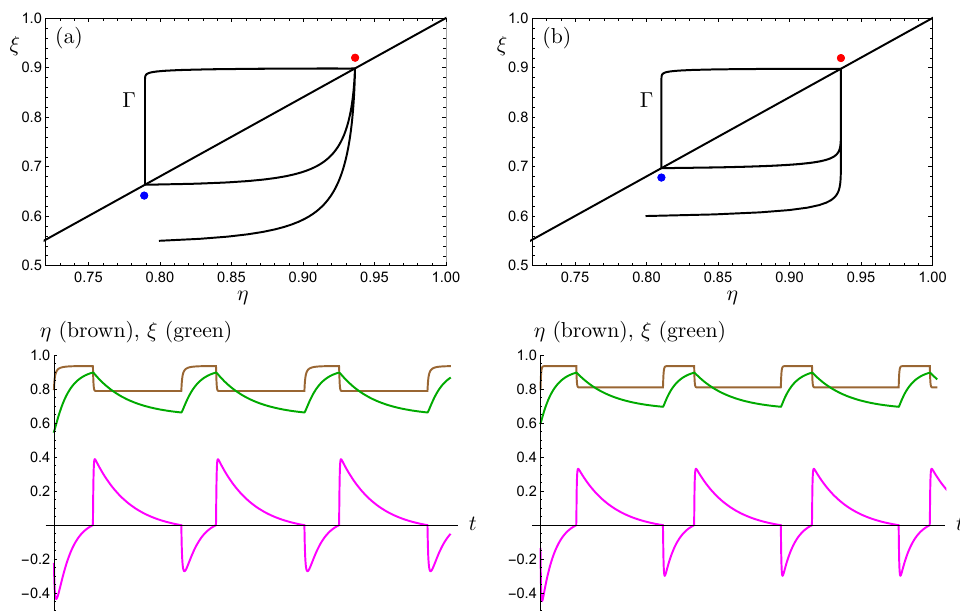
Figure 7. The limit cycle Γ for system (23) ( ρ = 0.1 R , (cid:101) = 0.03 R ). ( a ) N = 1, D G = 0.3, D I = 0.394. ( b ) N = 3, D G = 0.3, D I = 0.43. The magenta curve is a plot of the critical mass balance expression a ( 1 − η ) − b ( η − ξ ) evolving with